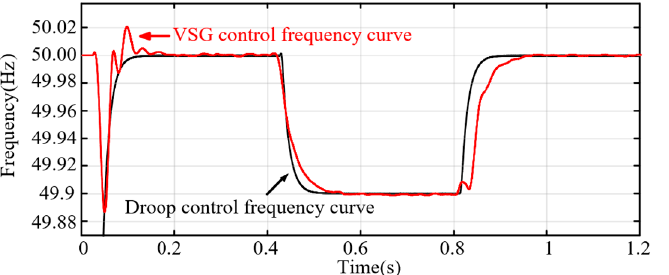
Figure 10. Experimental results for frequency waveform comparison of droop control and VSG control.